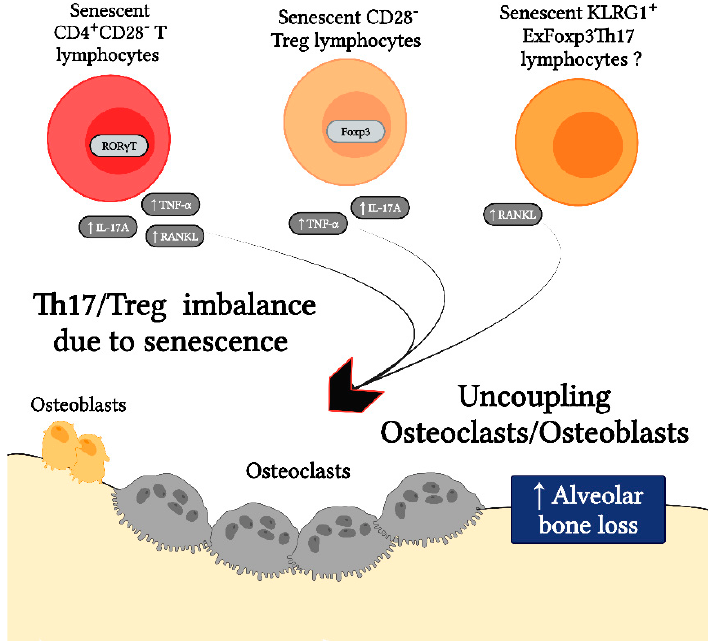
Figure 5. Senescence in the CD4 + T cell compartment leads to Th17/Treg imbalance that can trigger osteoclast/osteoblast uncoupling and alveolar bone loss. Senescent CD4 + CD28 - T lymphocytes are biased to Th17-like polarization and function, which is evidenced by their increased expression of the transcription factor retinoic acid receptor-related orphan nuclear receptor- γ t (ROR γ t), the bone resorptive factor receptor activator of NF- κ B ligand (RANKL), and the cytokines interleukin (IL)-17A and tumor necrosis factor (TNF)- α , presumably as part of their senescence-associated secretory phenotype (SASP). Similarly, senescent Foxp3 + CD4 + CD28 - Tregs show features of phenotypic instability, such as lower suppressive capacity and production of IL-17A and TNF- α . Furthermore, Tregs that lose Foxp3 expression and express the signature senescent marker killer cell lectin-like receptor G1 (KLRG1) also produce higher amounts of RANKL. All of these senescent T cells can lead to osteoclast/osteoblast uncoupling in favor of osteoclast differentiation and activation, resulting in increased tooth-supporting alveolar bone loss.